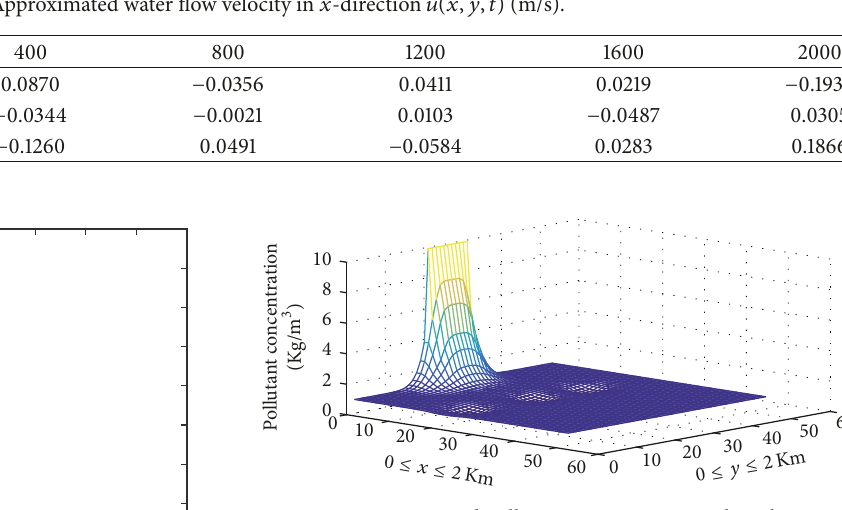
Figure 8: Approximated pollutant concentrations when the second zonal removal mechanism system is activated.